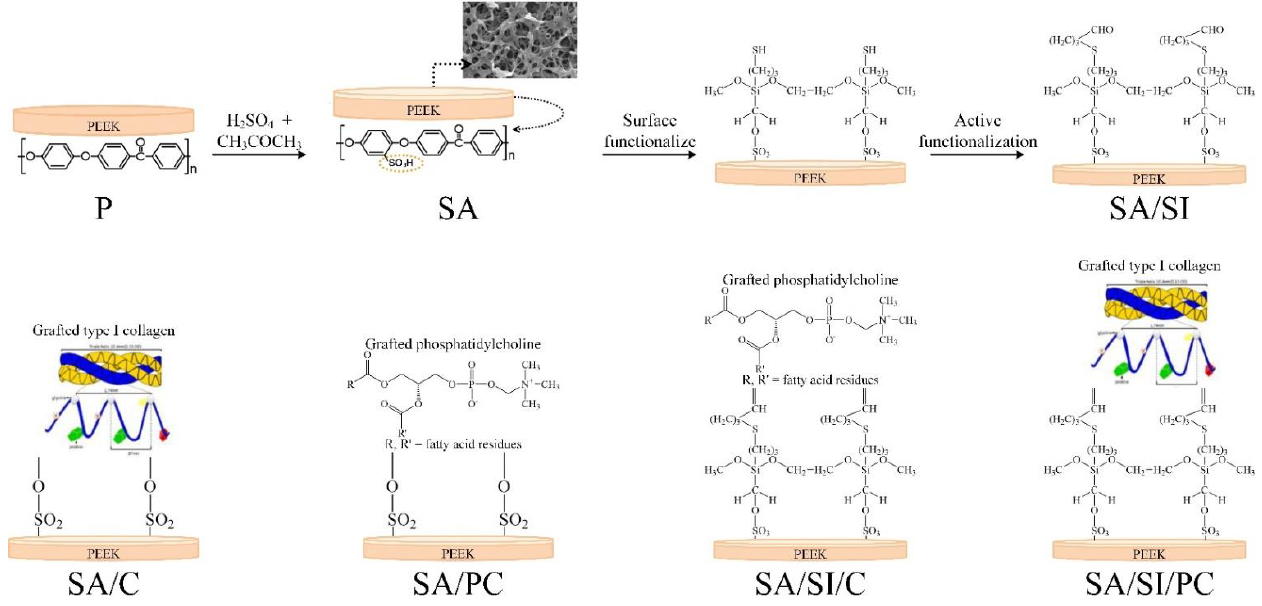
Figure 1. Schematic diagram of biopolymer grafting with PEEK surface modification. The sample dimension used in this experiment after PEEK sulfonation would expand, which increased in size and varied slightly with an outer diameter of approximately 8.28 ± 0.03 mm from 7.99 ± 0.02 mm (Figure 2a). Under OM observation, a sulfonated layer appeared around the test specimen (SA), and the thickness of the sulfonated layer was 269.35 ± 42.34 µ m ( n = 250; Figure 2b). The PEEK surface had evenly distributed